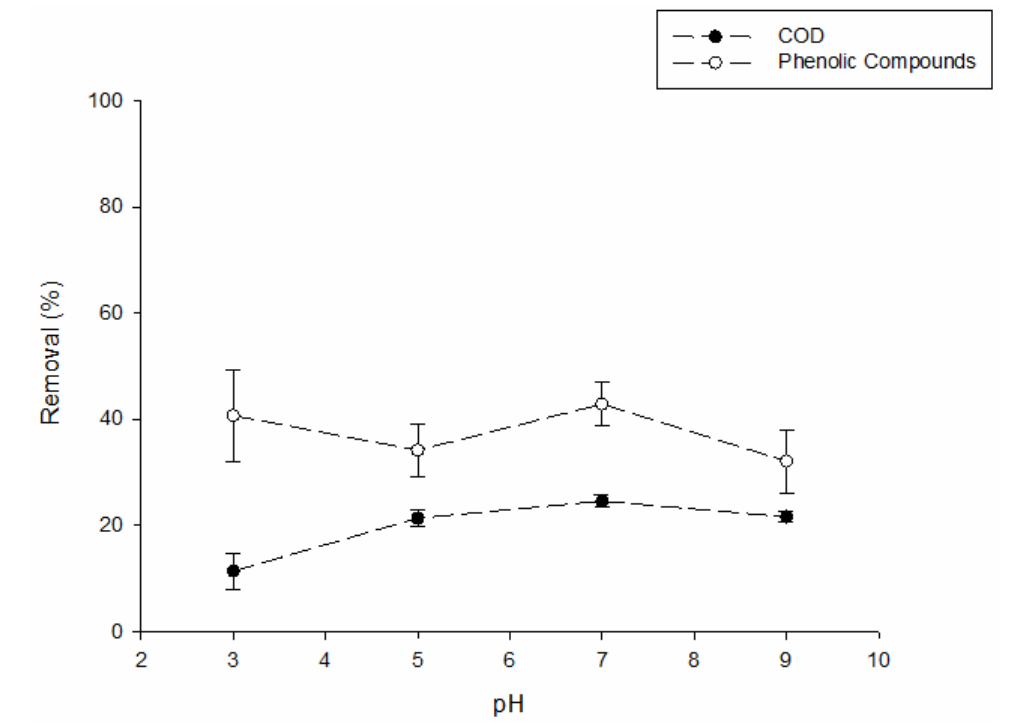
Figure 5. Initial pH influence on COD and phenolic compounds removal during PMS activation by UV-A light (1600 mg/L of PMS after 15 min of reaction).